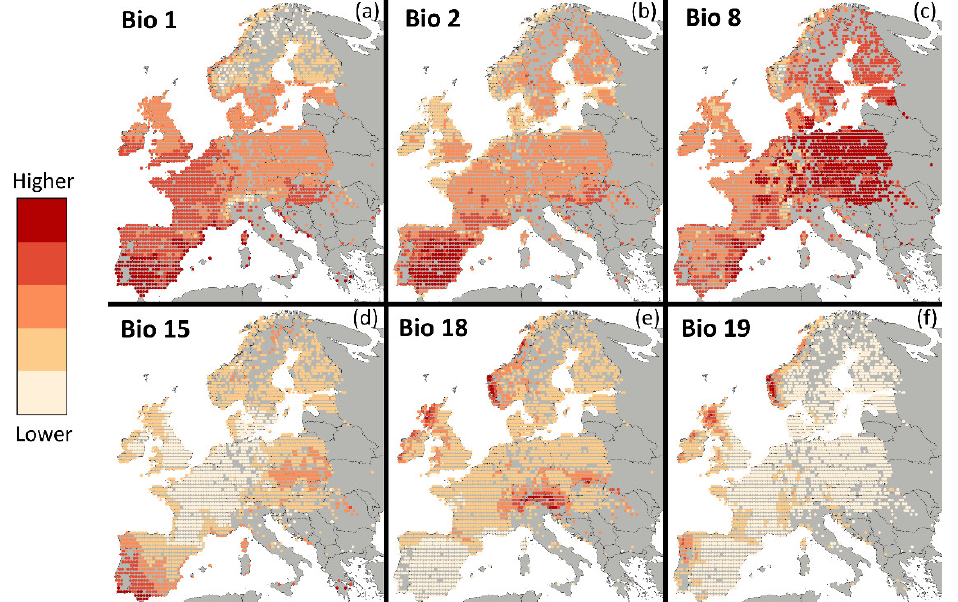
Figure 2. Values of the 6 climatic variables: ( a ) Annual Mean Temperature (Bio 1), ( b ) Mean Diurnal Range (mean of the monthly maximum temperature subtracted by the monthly minimum temperature) (Bio 2), ( c ) Mean Temperature of Wettest Quarter (Bio 8), ( d ) Precipitation Seasonality (Bio 15), ( e ) Precipitation of Warmest Quarter (Bio 18), and ( f ) Precipitation of Coldest Quarter (Bio 19). Darker tones represent higher values of the variable. The values are climatic normals from 1960 to 1990, obtained from WorldClim at a resolution of 10 arcminute and downsampled to the same resolution as the presences (35 km × 35 km) by averaging the values inside each grid. The colour scale divides the total range of each variable in five sections of equal range. The map projection is World Mollweide.